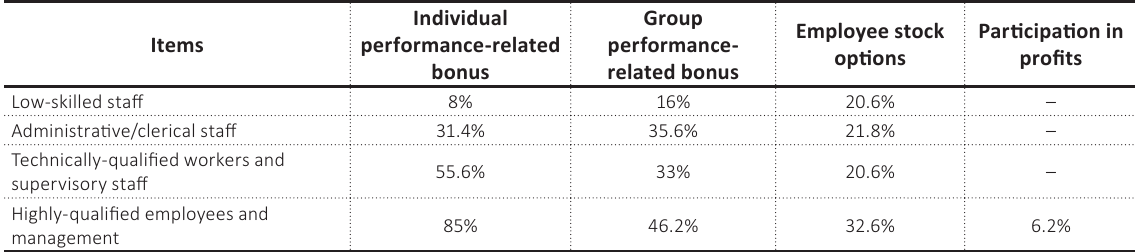
Table 3. Flexible benefits to employees per professional category